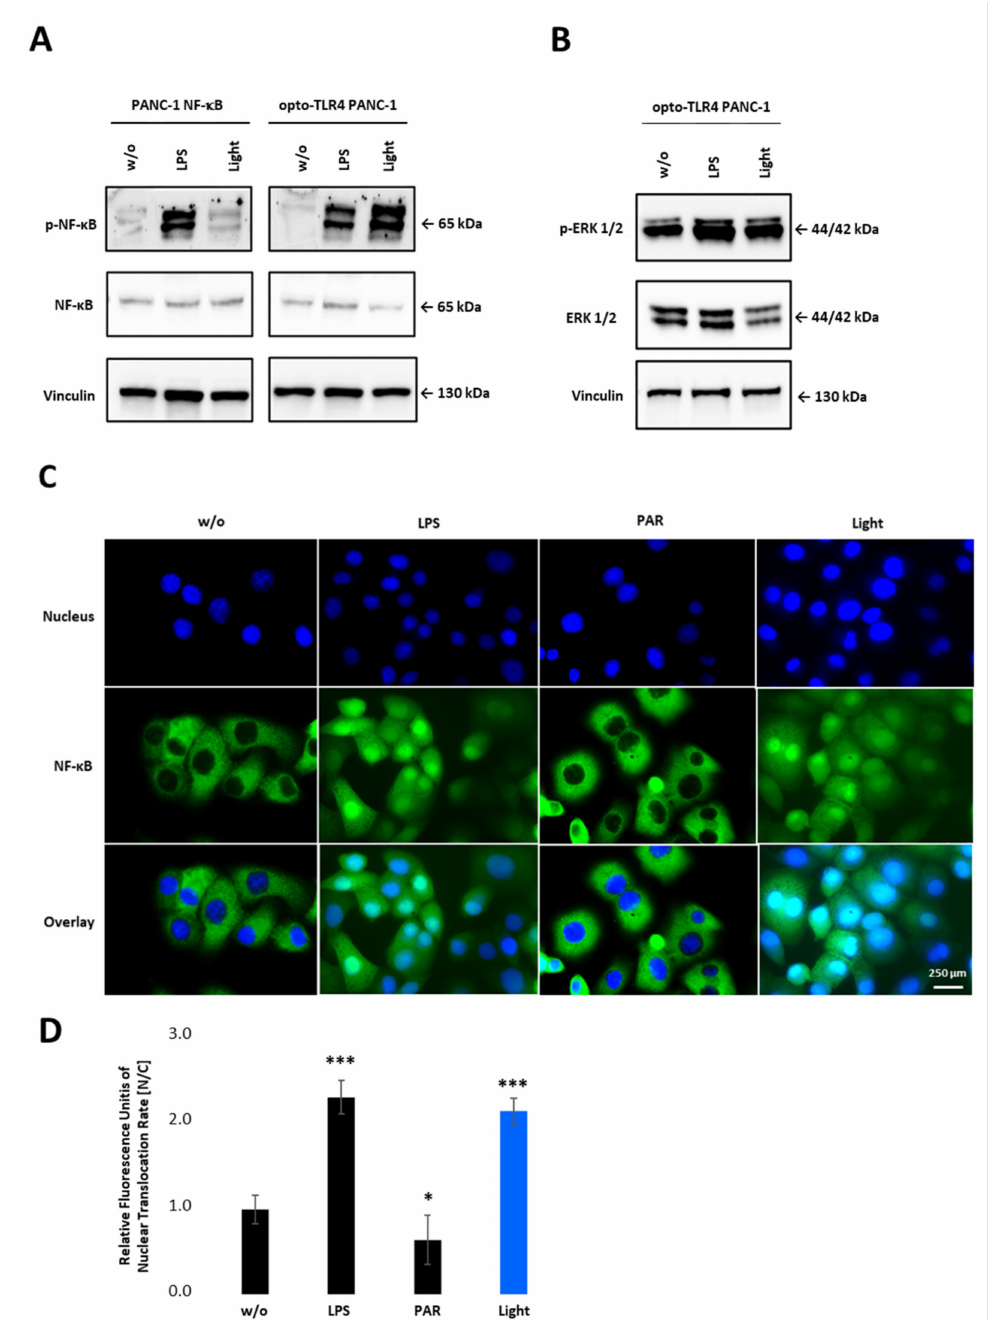
Figure 4. NF- κ B activation upon illumination of opto-TLR4 PANC-1. ( A ) Western blot analysis with antibodies against phospho-p65, p65 and ( B ) phosphor-ERK1/2 and ERK1/2 30 min after light or LPS (100 ng/mL) stimulation. Vinculin was used as the reference gene. ( C ) Nuclear localisation of p65 after LPS (100 ng/mL) or light (470 nm, 7.5 min) stimulation compared to untreated cells or cells treated with PAR (3 µ M). ( D ) Relative Fluorescence units of nuclear localisation of p65 [nucleus/cytoplasm]. Post-ANOVA multiple comparisons relative to the control were performed using Dunnett’s test. Error bar = SD. n = 5; * p < 0.05; *** p <